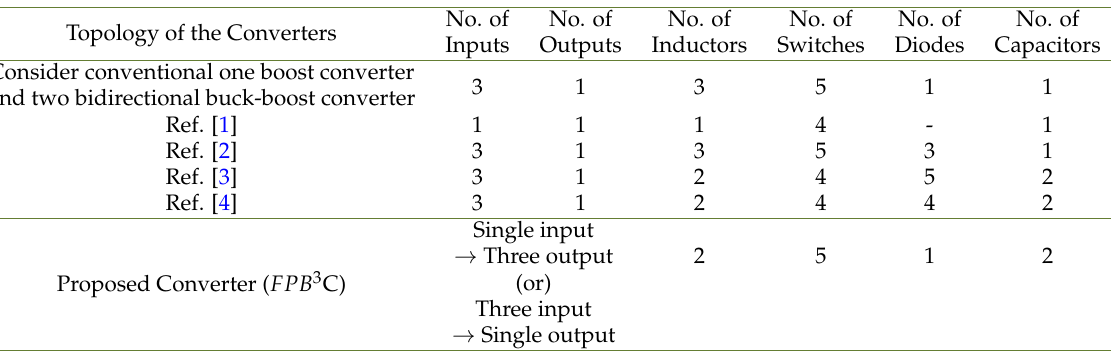
Table 1. Comparison Table of Proposed Multiport Bidirectional Buck-Boost Converter with Other Conventional Similar Converters No. of No. of No. of No. of No. of No. of Topology of the Converters Inputs Outputs Inductors Switches Diodes